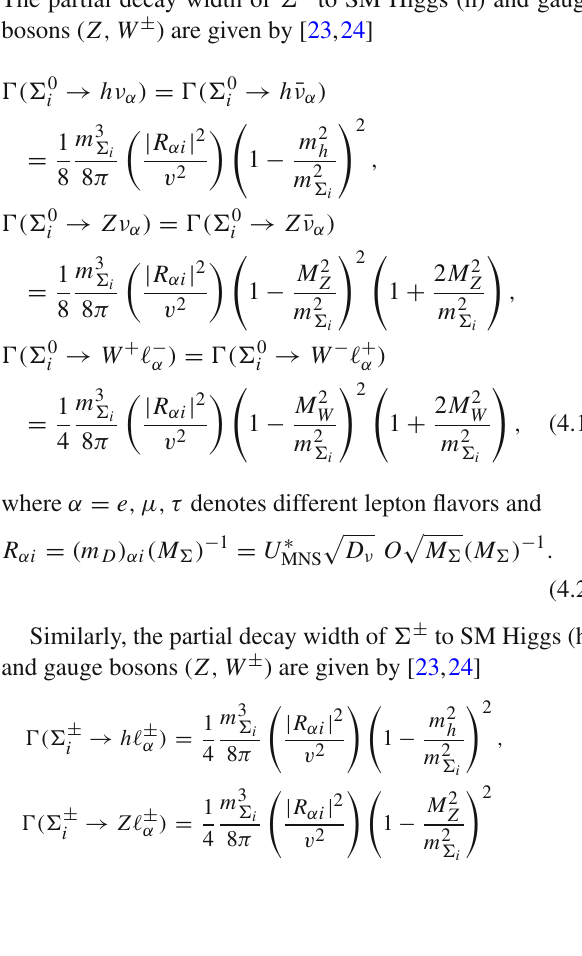
produced via vector boson-fusion process in association with two forward jets (its diagram is similar to the right diagram in Fig. 3). Despite a large production rate, this process suffers from larger QCD background due to the forward jets activity and is sub-dominant 4 compared to the Drell–Yan